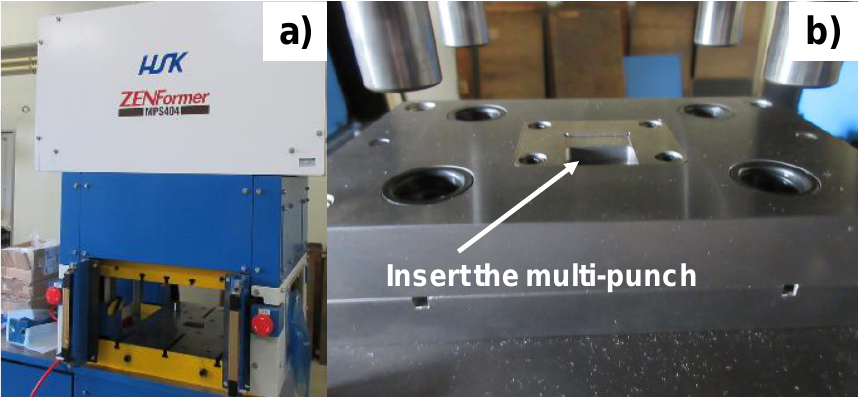
Figure 3. Mechanical blasting equipment. ( a ) Overall image of blasting equipment and ( b ) the shooting stage of substrates in manual operation.